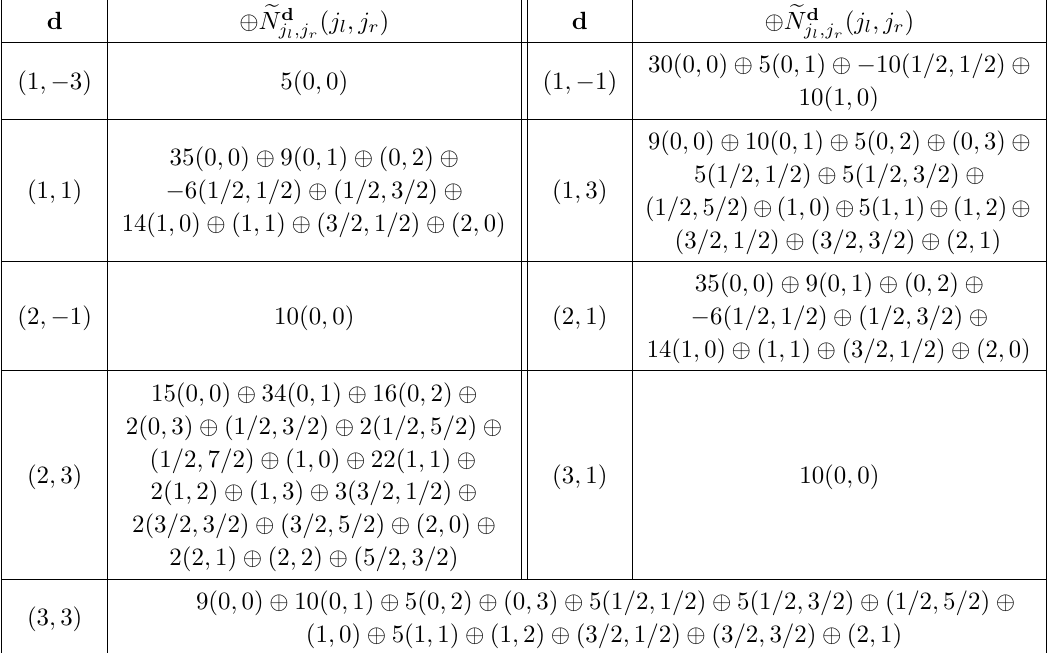
Table 8 . Pseudo-BPS Spectrum of SU(2) Wilson loop expectation value in the representation 2 ⊗ 5 for the curve class d 1 m 0 + d 2 φ with d 1 = 1 , 2 , 3 , and d 2 ≤ 3 . The d 1 = 0 part can be read from (3.73).